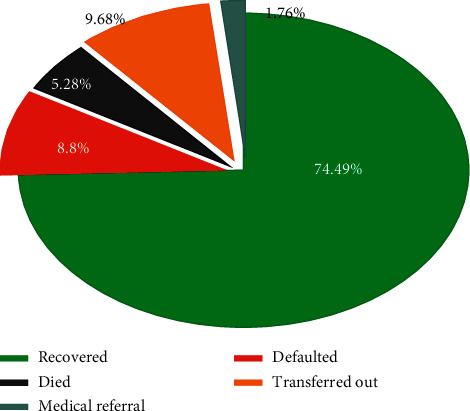
Treatment outcomes of 6–59 months children with severe acute malnutrition in East Amhara Hospitals, Ethiopia, 2019.